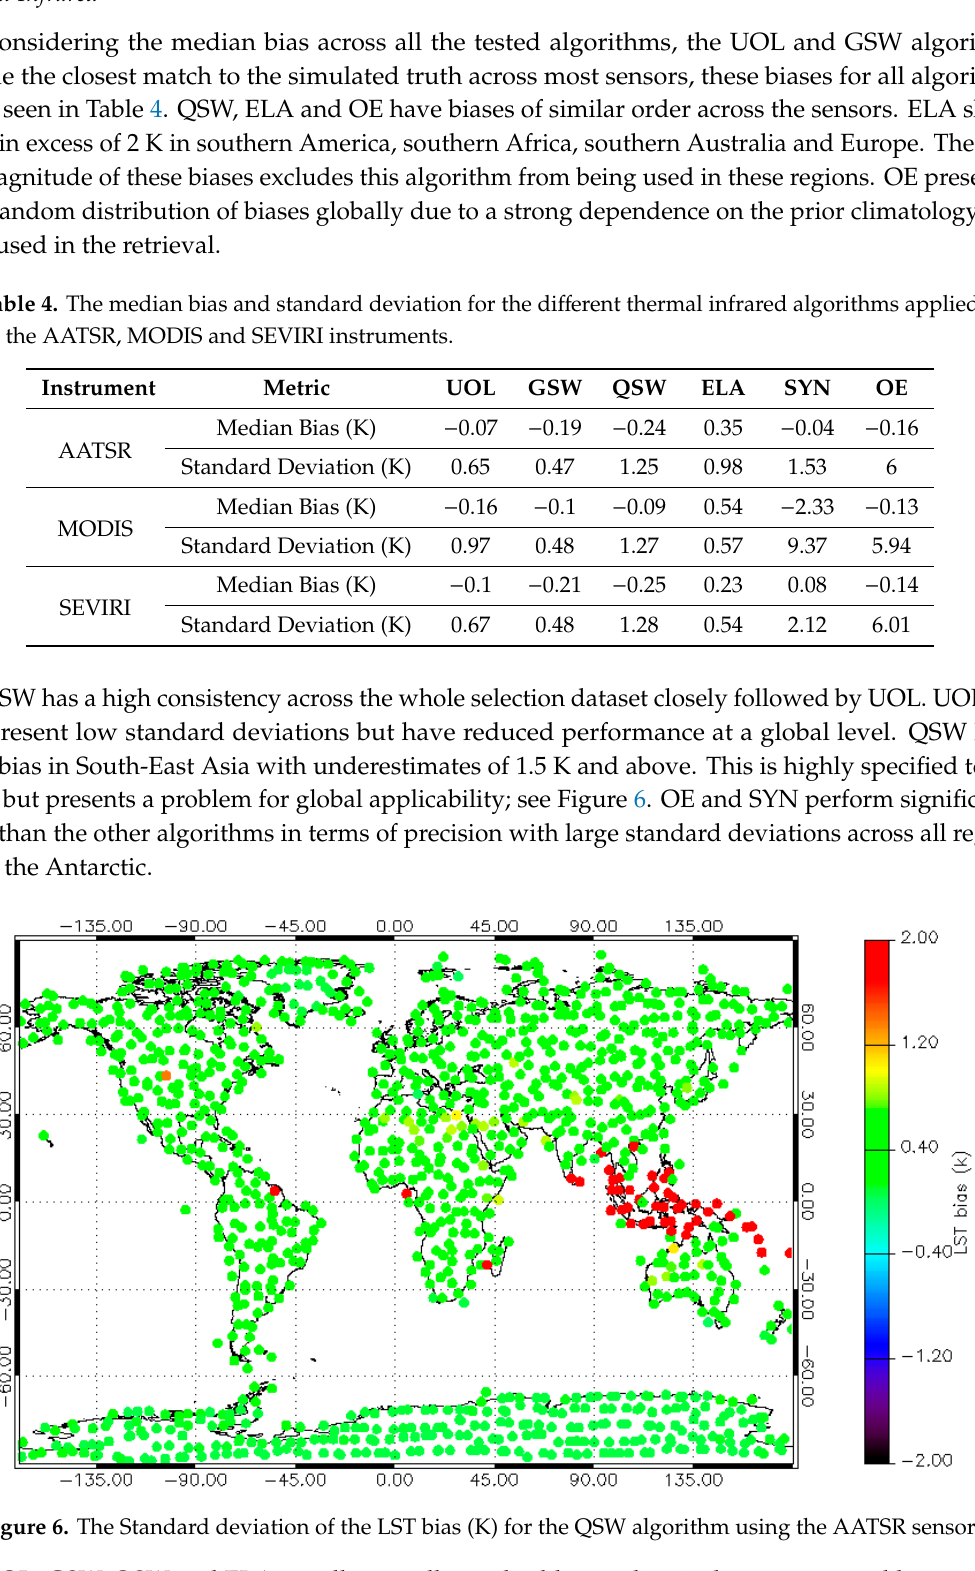
Figure 6. The Standard deviation of the LST bias (K) for the QSW algorithm using the AATSR